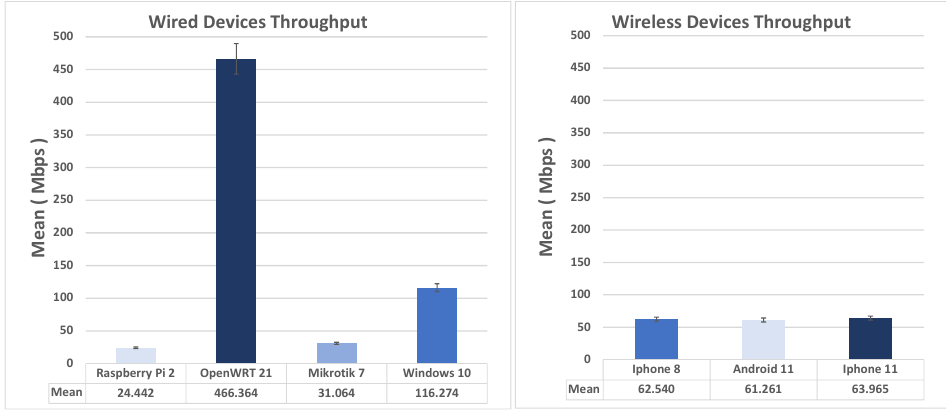
Figure 6. Comparison of the average Throughput in IKEv1-L2TP Road Warriors